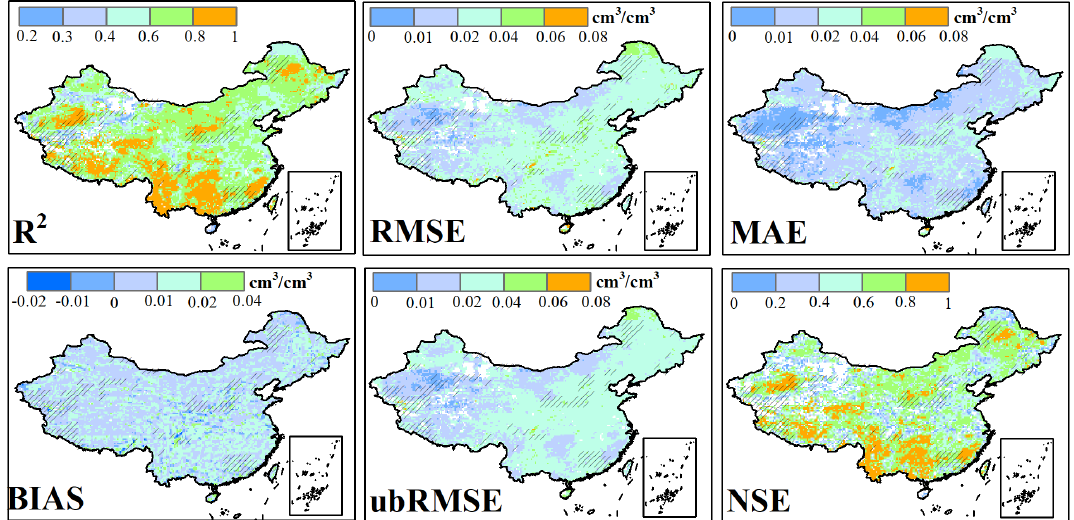
Figure 9. Spatial distributions of accuracy metrics of 10 cross-validations in 2009 for R 2 , RMSE, MAE, BIAS, ubRMSE, and NSE. The slash represents the regions impacted by